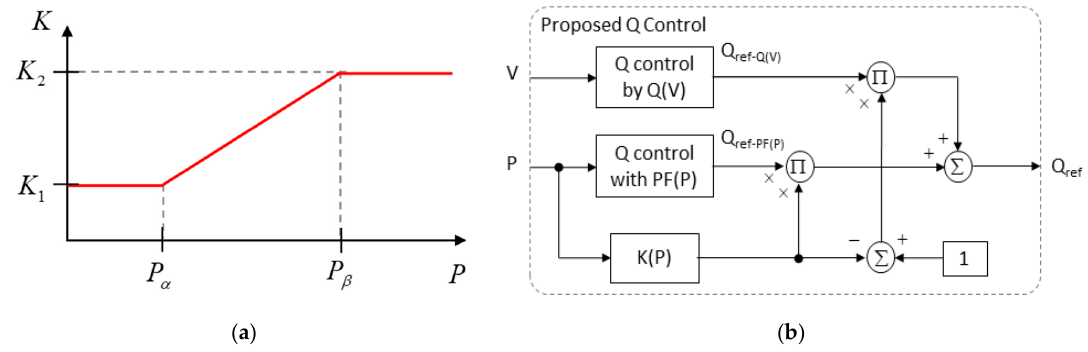
Figure 8. Weight factor K as a function of active power P and Block diagram for proposed method; Figure 7. Weight factor 𝐾 as a function of active power 𝑃 and Block diagram for proposed method; ( a ) weight factor K as a function of active power P ; ( b ) Block diagram. ( a ) weight factor 𝐾 as a function of active power 𝑃 ; ( b ) Block diagram .